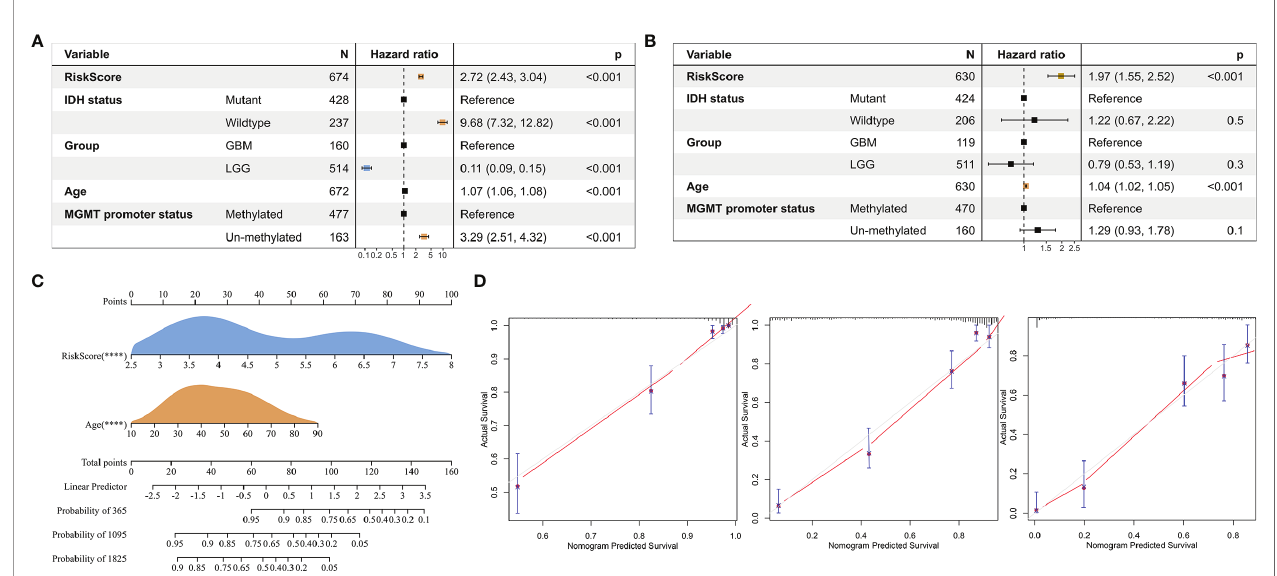
FIGURE 9 | Risk score is an independent prognostic factor for glioma. (A) Univariate Cox regression analysis of the clinical phenotypes such as the risk score, age, MGMT promoter status, WHO grade, and IDH status. (B) Multivariate Cox analysis showed that the risk score was associated with the prognosis. (C) The nomogram was used to predict prognosis in patients at 1, 3, and 5 years in TCGA GBMLGG cohort. (D) Calibration curves showed the difference between the survival rate predicted by the model and the actual rate at 1, 3, and 5 years. ****, p < 0.0001.